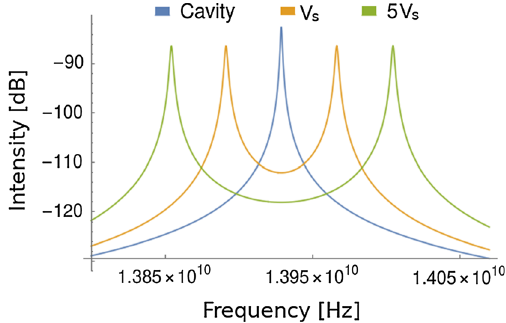
Fig. 2 Power spectrum of the cavity (blue line), and hybrid modes calculated for a critically coupled antenna and a sample volume V s (orange line) and 5 V s (green line). The used parameters are close to the experimental values of our